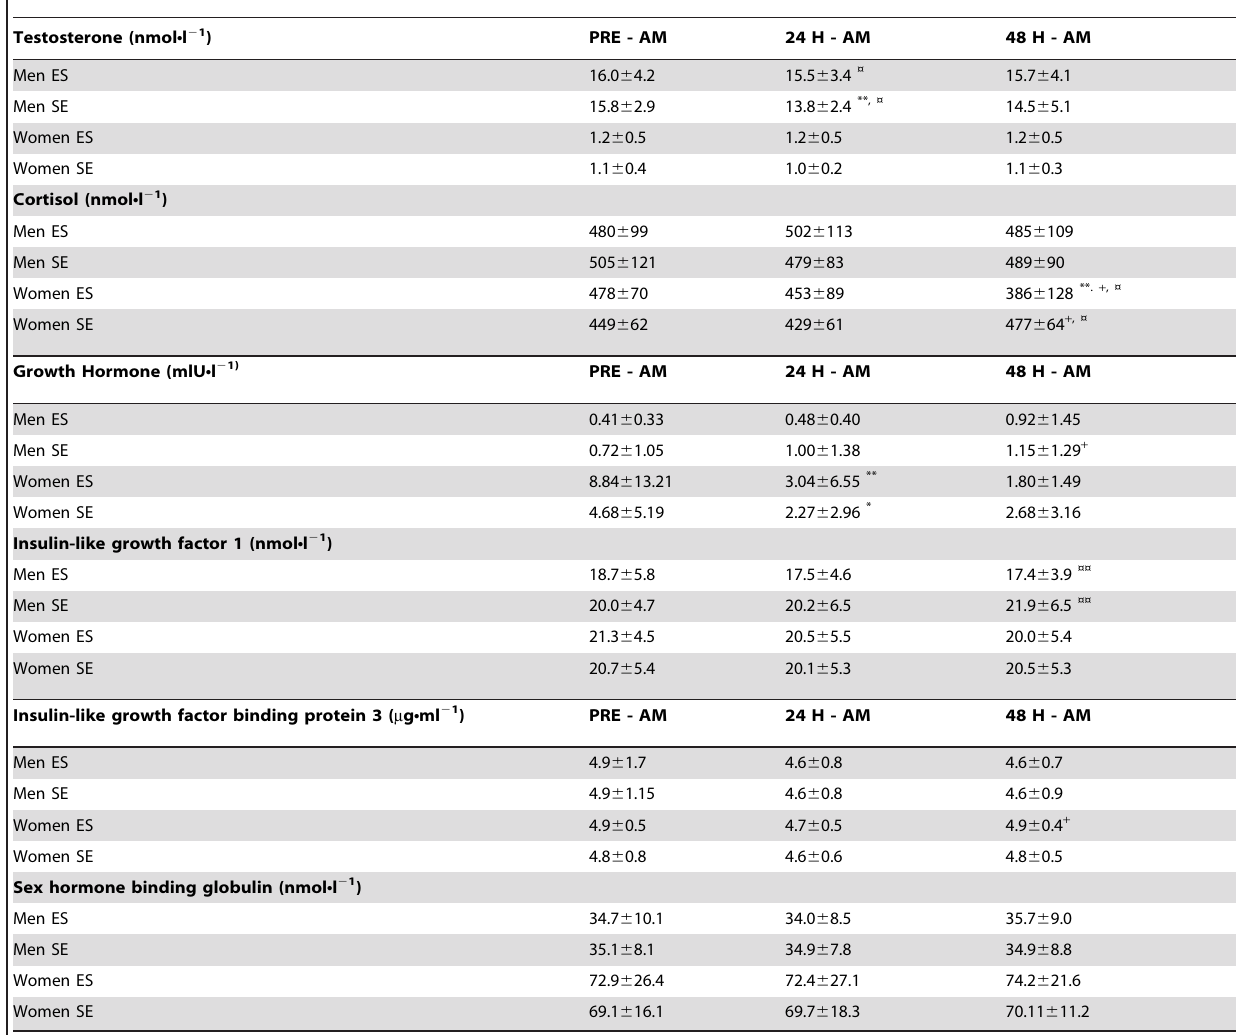
Table 3. Absolute morning concentrations of serum